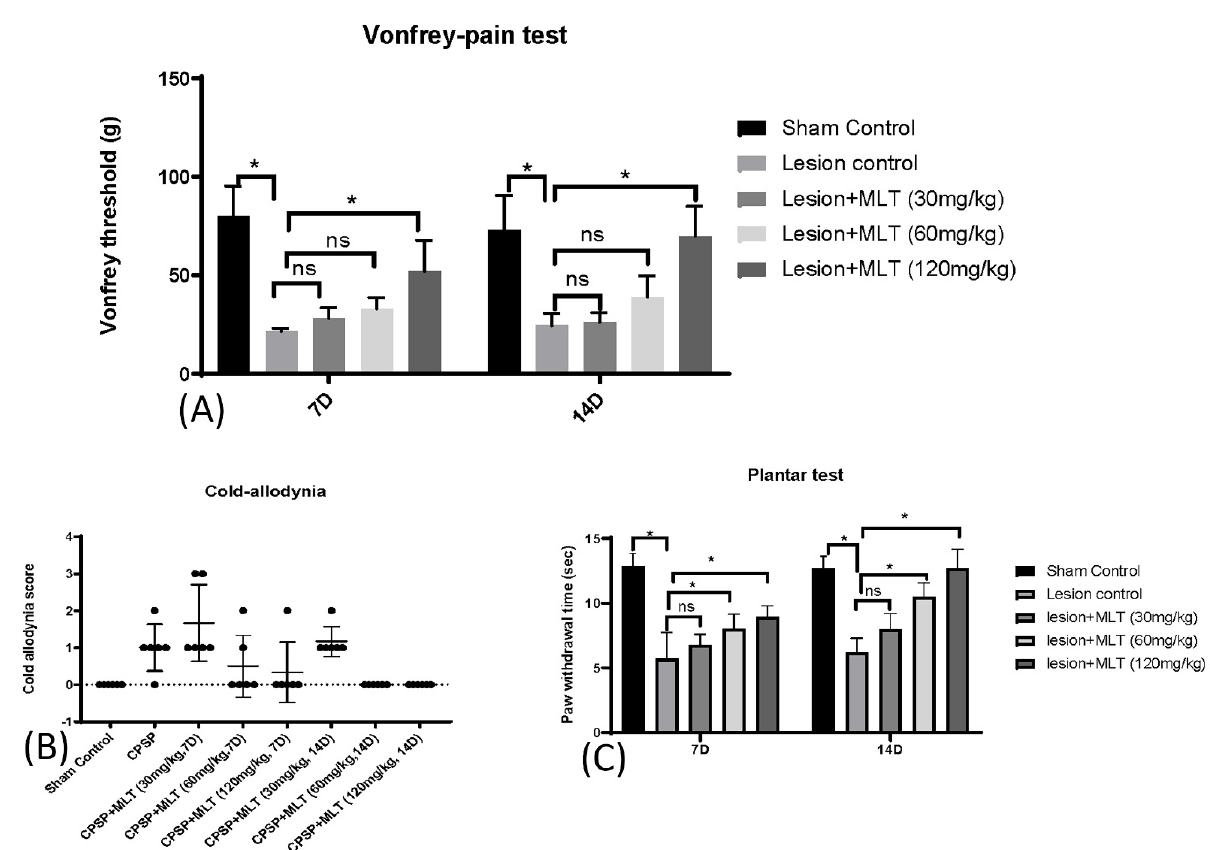
Figure 2. Effects of melatonin treatments on various pain tests, including Vonfrey pain, plantar, and cold allodynia tests. ( A ) Effect of melatonin administration on paw withdrawal threshold (g) in rats during a Von Frey pain test on days 7 and 14 after thalamic hemorrhage (n = 5, per group). Data expressed as mean ± SD. The figure shows pain hypersensitivity in central stroke rats 7 days and 14 days post ‐ injury, * p < 0.05. ( B ) Effect of melatonin administration in cold allodynia in rats on days 7 and 14 after thalamic hemorrhage (n = 6, per group). The cold allodynia scores, as accounted by paw withdrawal, were demonstrated more in CPSP rats as compared with the sham control; MLT (30 mg/kg, i.p.) gave the same response as CPSP rats (not shown in figure); MLT (60 mg/kg i.p.) showed an effective response, but some rats showed both prolonged and quick paw withdrawal responses, whereas MLT (120 mg/kg i.p.) demonstrated a much better effect on CPSP rats. The cold allodynia score was almost zero on the 14th day of melatonin administration, which suggests a healing effect of melatonin. ( C ) Effect of melatonin administration on paw withdrawal latency in plantar test in rats on days 7 and 14 after thalamic hemorrhage (n = 5, per group). Data expressed as mean ± SD. The figure shows pain hyperalgesia in central stroke rats 7 days and 14 days post ‐ injury, * p < 0.05.